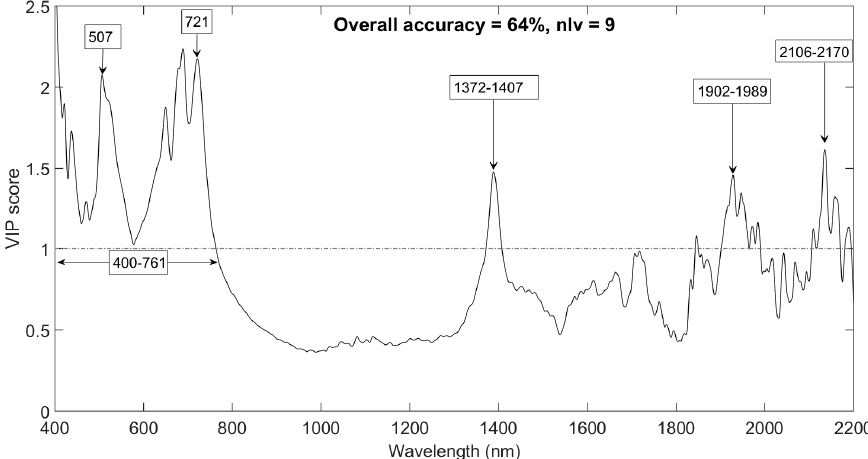
Figure 7. Key wavelengths that enhance leaf sample discrimination. Canopy position was used as the discrimination group.